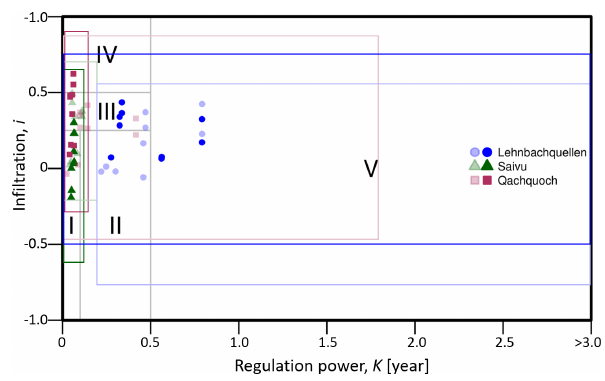
Figure 6. Karst aquifer type classification based on mean values of K and i calculated with recession parameters estimated by the different combinations of REM and POA for both summer (full- shaded color) and winter (light-shaded color) periods. Distributions of the per-event mean K and i derived from all method combi- nations for each spring are represented by colored symbols; areas covered by unfilled boxes are the standard